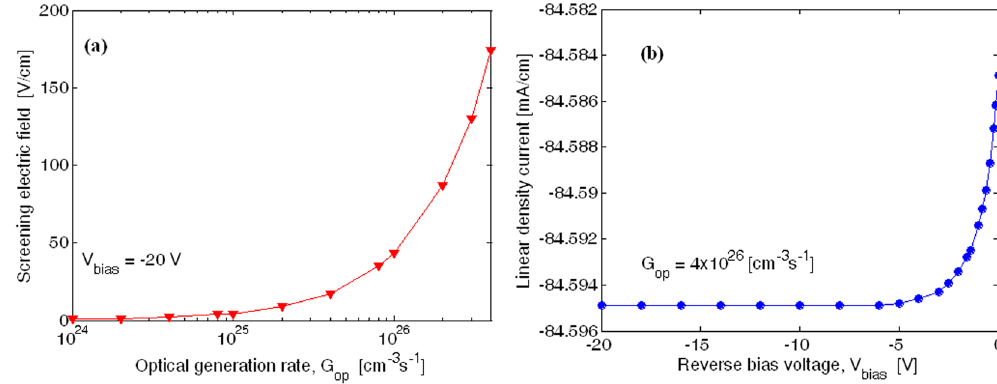
Figure 4. ( a ) Screening electric field as a function of the optical generation rate, for − 20 V of bias voltage. ( b ) Linear density current at the p-i-n electrode as a function of the reverse bias voltage, for G op = 4 × 10 26 cm − 3 s − 1